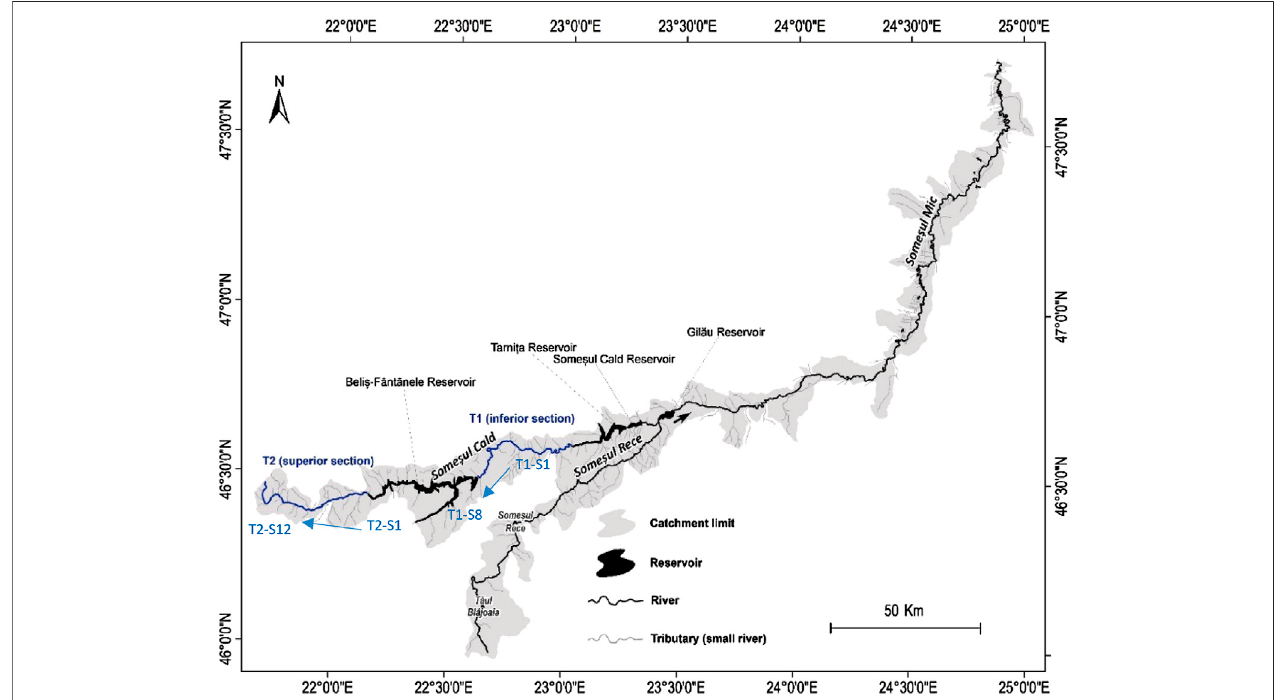
FIGURE 1 | River sections T1 and T2 from Some ș ul Cald River catchment after dam construction project. (source: the authors).